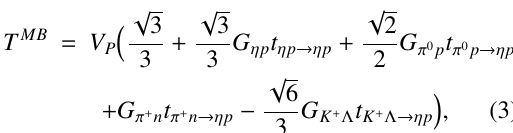
Figure 3. Diagrams for the Λ + vertex at tree level, (b) final-state interaction of the η p